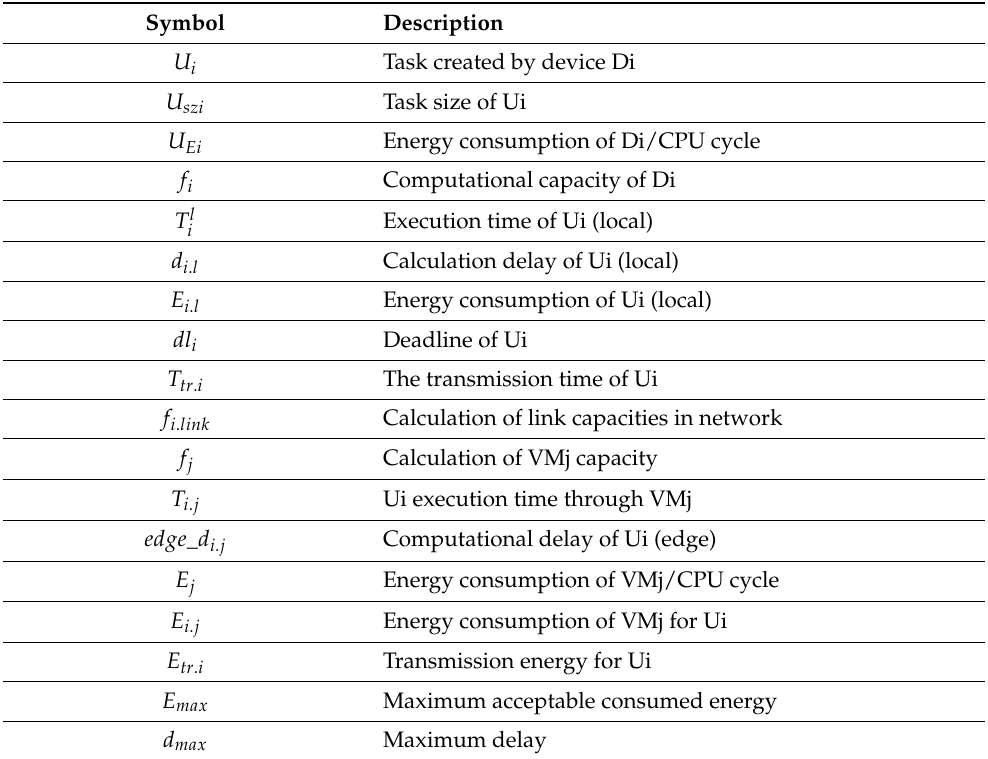
Table 1. List of